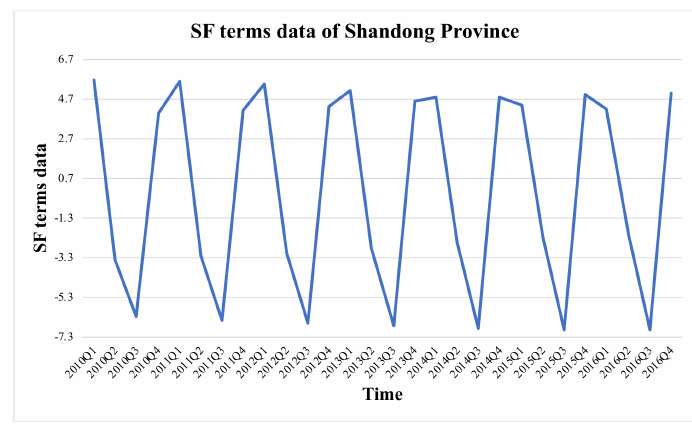
Figure 11. SF terms data of Shandong